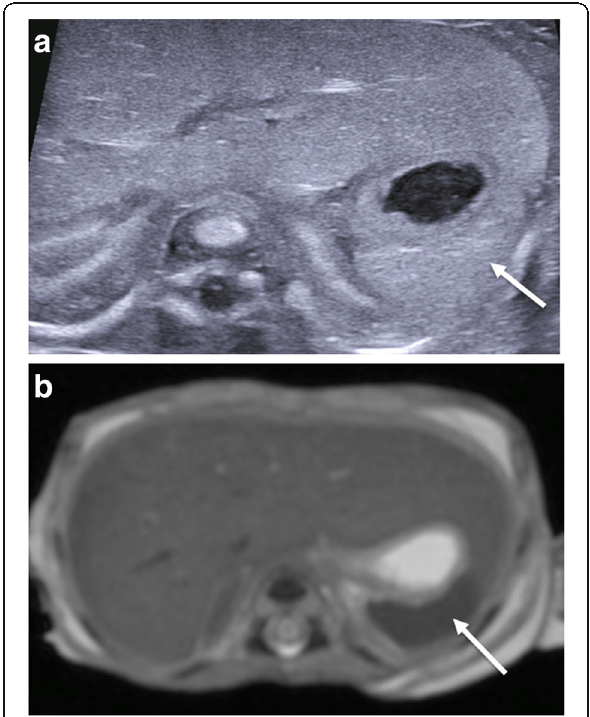
Fig. 16 Normal appearances of the liver and spleen in a 19-week gestational-aged foetus following miscarriage, imaged 6days after death. The transverse postmortem ultrasound imaging ( a ) through the upper abdomen demonstrates a very similar echogenicity of the liver with the spleen (white arrow). The differences between the two organs is much better seen at T2-weighted postmortem MRI ( b ), where both organs demonstrate different signal intensities